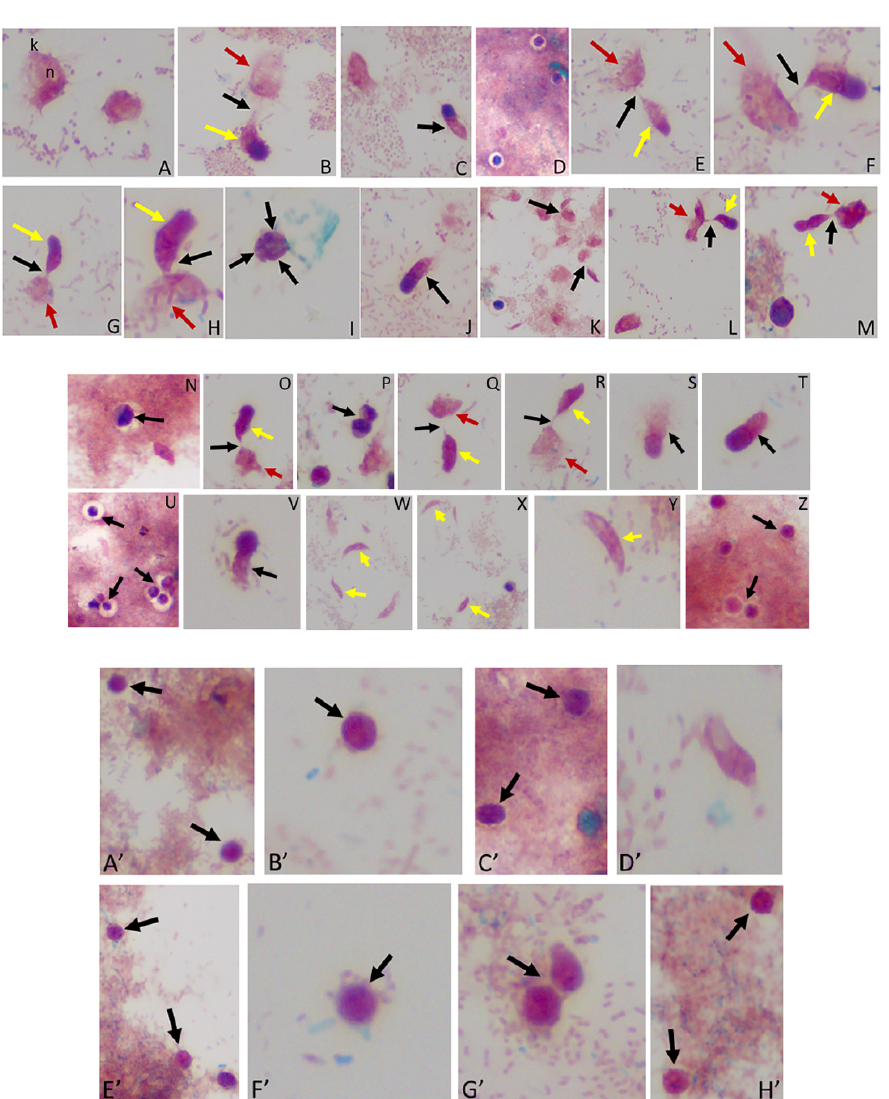
Figure 3. ( A – M ): Time course experiments showing development and timing of life cycle stages ( A , B 20 h), ( C , D 22h), ( E , F 24 h), ( G – I 25 h), ( J , K 26 h), and ( L , M 27 h). Kinetoplast (k) and nucleus (n) of Parabodo caudatus is shown in panel ( A ). Black arrows in panels ( B , E – G , H , K – M ) identify tubular tethers between Colpodella sp. (ATCC 50594) (yellow arrows) and P. caudatus (red arrows). Black arrowheads identify pre-cysts. A mature cyst of Colpodella sp. (ATCC 50594) is shown in panel I. Young demilune cysts of Colpodella sp. (ATCC 50594) shown in panel ( D ). ( N – Z ): Time course experiments showing development and timing of life cycle stage transitions in culture. ( N , O 28 h), ( P , Q 29 h), ( R – T 30 h), ( U , V 32 h), ( W , X 34 h) and ( Y , Z 36 h). Young demilune cysts are shown in panels ( N , P , U ). Yellow arrows identify Colpodella sp. (ATCC 50594) trophozoites in myzocytosis with P. caudatus prey (red arrows) in panels ( O , Q , R ). Black arrows identify tubular tethers. Black arrowheads in panels ( S , T , V ) identify pre-cysts of Colpodella sp. (ATCC 50594). Young trophozoites of Colpodella sp. (ATCC 50594) were identified in panels ( W – Y ) and mature cysts of Colpodella sp. (ATCC 50594) were seen in panel ( Z ). Zones of inhibition/clear zones were observed surrounding and separating cysts of Colpodella sp. (ATCC 50594) from bacteria (antibacterial zone). ( A’ – H’ ): Time course experiments showing development and timing of life cycle stage transitions in culture. ( A’ , B’ 38 h), ( C’ , D’ 40 h), ( E’ , F’ 5 days) and ( G’ , H’ 7 days). Mature cysts of Colpodella sp.